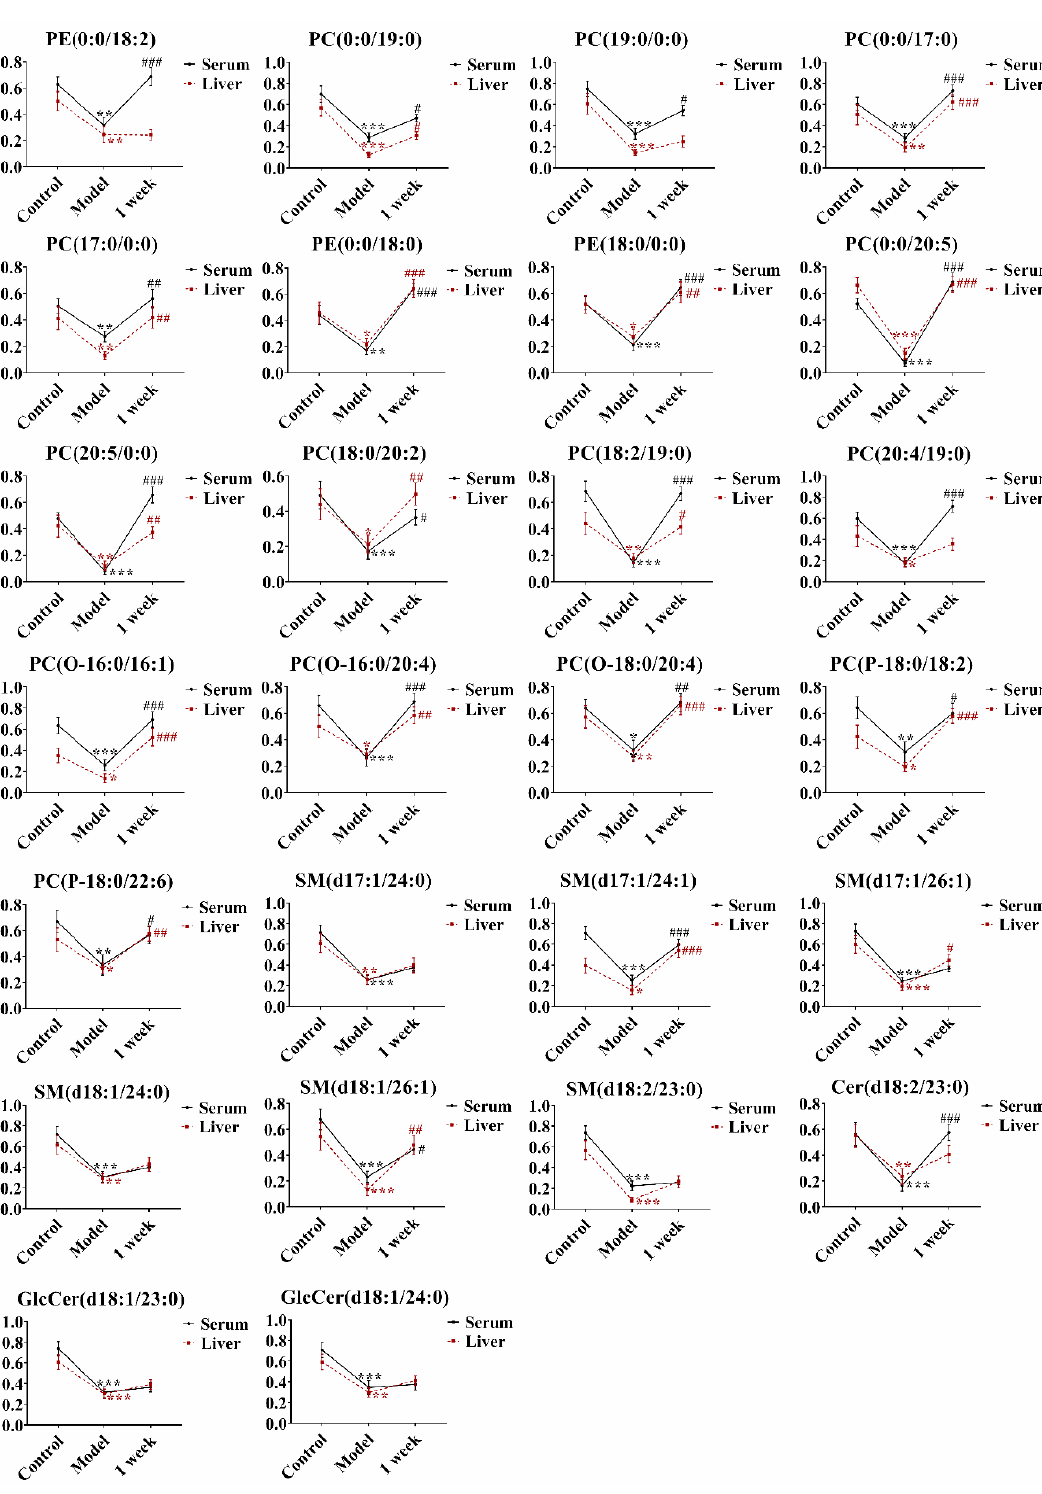
Figure 4. The tendency of level variation of significantly di ff erentially expressed lipids in both liver and serum in the control group, AAI group, and one-week group. * P < 0.05, ** P < 0.01, and *** P < 0.001, the control group compared to the AAI group. # P < 0.05, ## P < 0.01, and ### P < 0.001, one-week group compared to the control group.